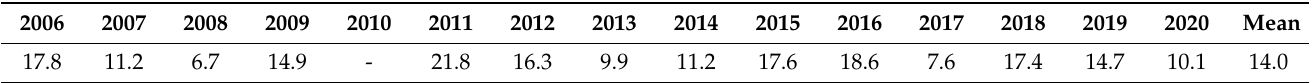
Table A2. Relationship (in%) of the potential gradient values numbers under fair-weather conditions and under different weather conditions in Tomsk according to data from the IMCES GO for 2006–2020. Data of potential gradient for 2010 are missing due to the repair and calibration of the field mill in the Voeikov Main Geophysical Observatory (St. Petersburg, Russia).